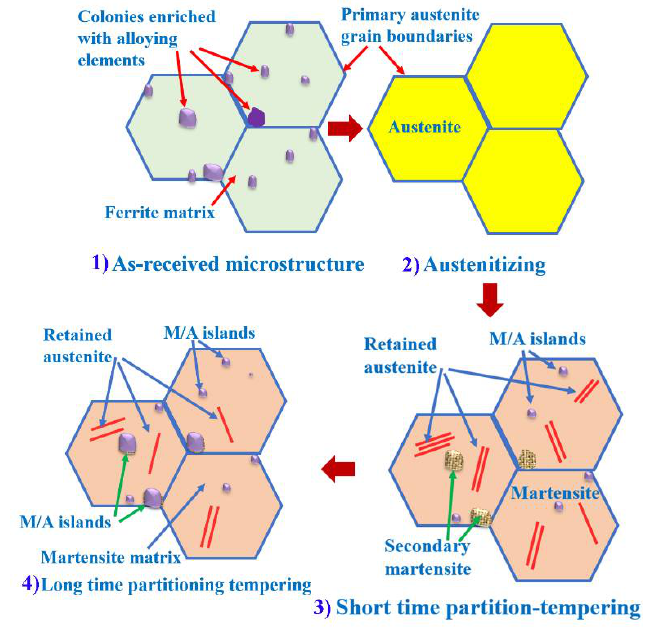
Figure 9. The schematic diagram illustrates the microstructural development of Q-P-T